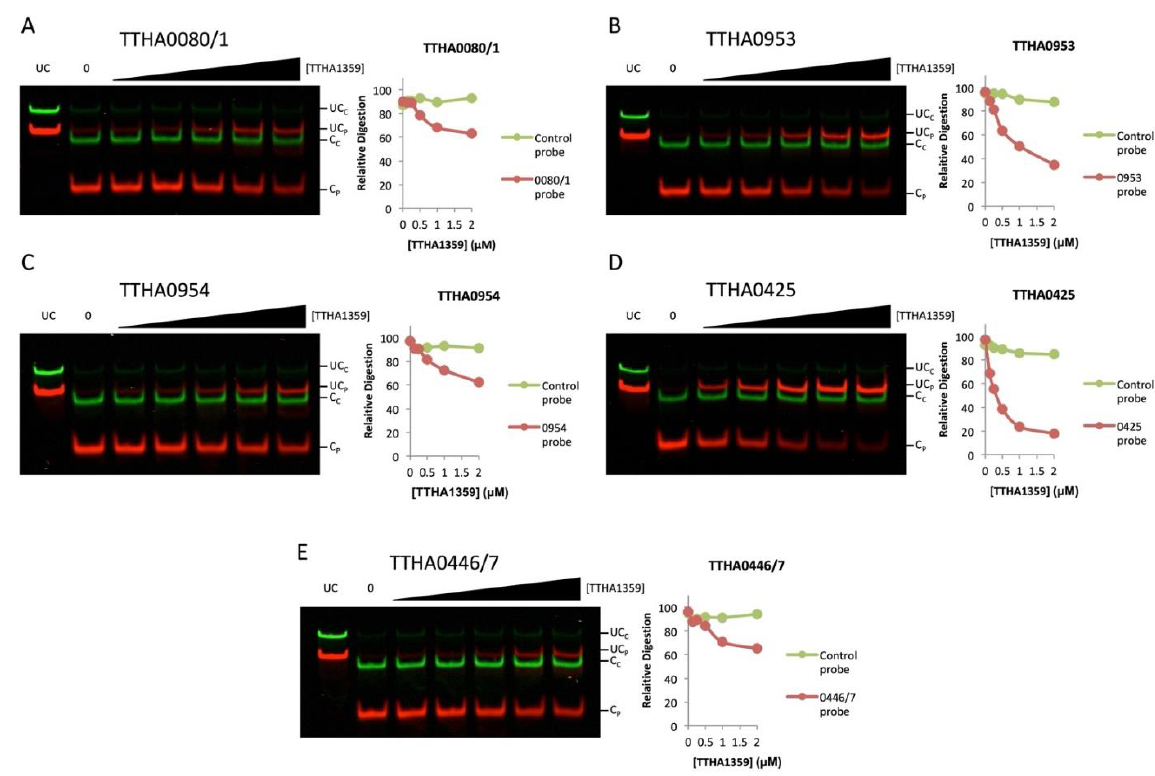
Figure 6. Validation of TTHA1359-regulated T. thermophilus HB8 promoters by REPA. DNA probes containing either a promoter region of the designated gene (red) or the REPSAis control sequence (green) were pre-incubated with increasing amounts of TTHA1359, ranging from 125 to 2000 nM monomeric protein (62.5 to 1000 nM dimeric protein), then subjected to restriction digest by the IISRE, BpmI. Levels of digestion for both DNA sequences were quantified and graphed. Band denotations: UC C , uncleaved control DNA; UC P , uncleaved promoter DNA; C C , cleaved control DNA; C P , cleaved promoter DNA. ( A ) TTHA0080/1 , ( B ) TTHA0953 , ( C ) TTHA0954 , ( D ) TTHA0425 , ( E ) TTHA0446/7 .